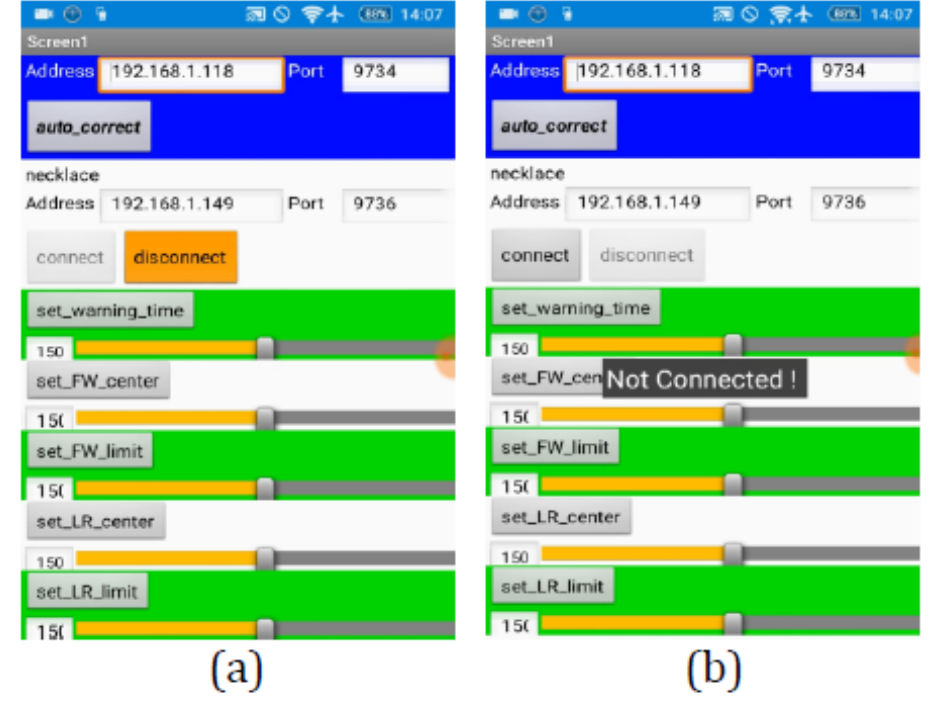
Figure 23. Deactivation of the smartphone’s function for receiving reminders from the smart